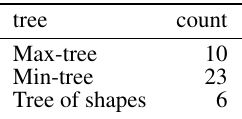
Table 1. Count of significant intersections (below 0 . 95 ) for each tree type.